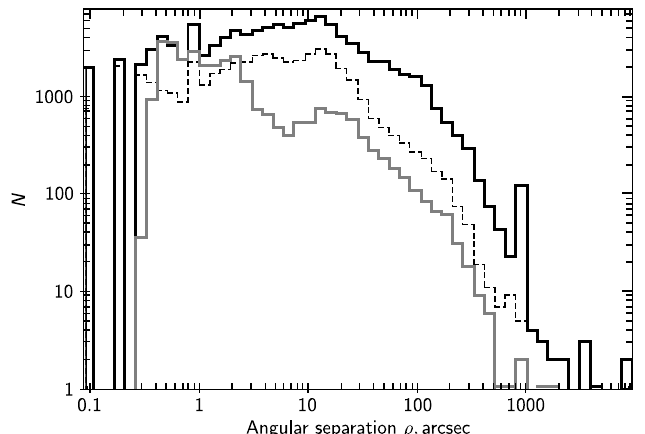
Fig. 1. Distribution of angular separations (cid:26) of the WCT pairs. The solid, dashed, and gray lines show the distributions for the WDS, CCDM, and TDSC data, respectively. The peaks at 0.1, 1.0, and 1000 arcsec (for the WDS data) are false and due to round-off